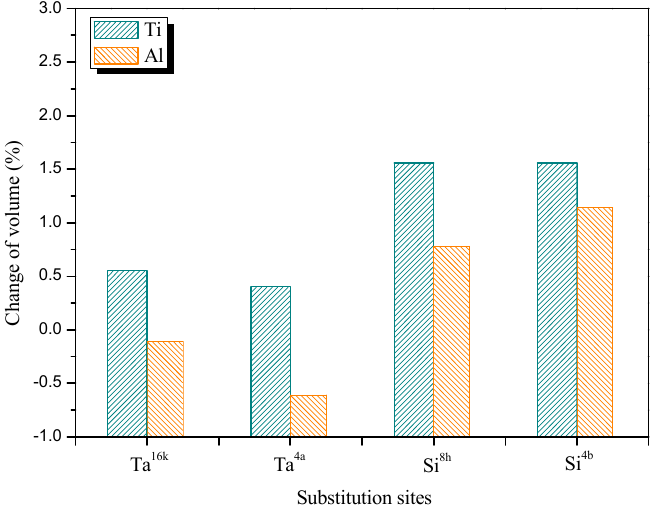
Figure 2. The change of unit cell volume for Ti and Al additions occupying the four possible substitution sites for D8 m ‐ structured Ta 20 Si 12 .